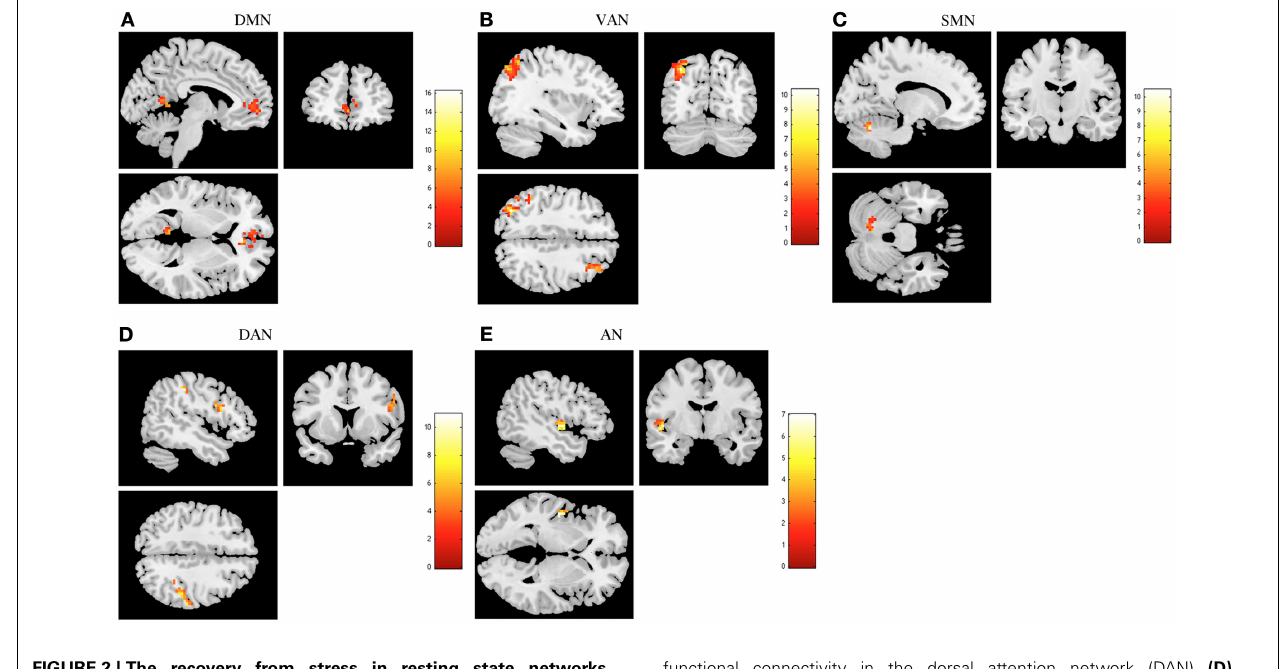
functional connectivity in the dorsal attention network (DAN) (D) and auditory network (AN) (E) . Results were extracted by independent component analysis and using paired t -tests, with results considered significant at a corrected for multiple comparisons p < 0 . 05 threshold.